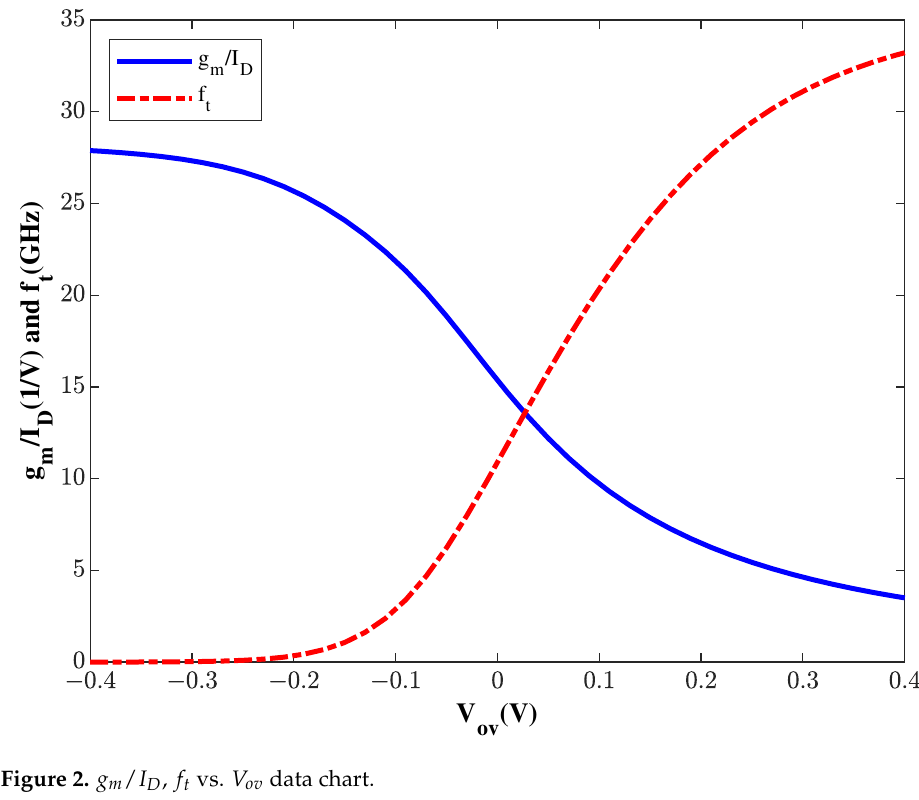
Figure 2. g m / I D , f t vs. V ov data chart.